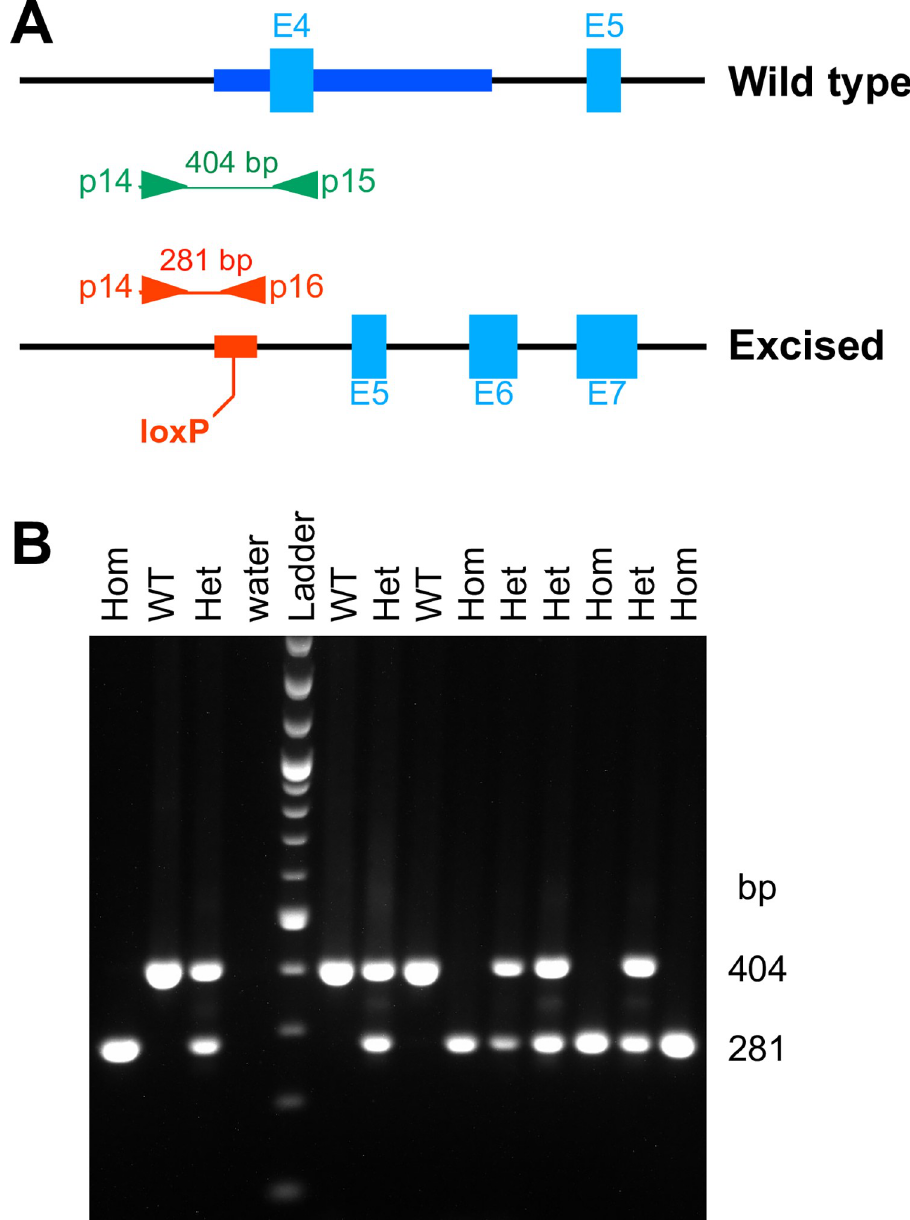
Fig 6. Production of excised Poldip2 mice. New floxed Poldip2 mice were crossed with a transgenic Cre deleter to produce animals with a constitutively excised Poldip2 allele. These mice were then backcrossed with wild type C57BL/ 6J to remove the Cre transgene and eliminate mosaicism. A: Design of a genotyping method for the excised Poldip2 allele. The genomic maps show the annealing sites of three primers and corresponding amplicons from wild type (top, green) and excised alleles (bottom, red). The 641 bp region around exon 4 (E4) in wild type, highlighted in dark blue, is replaced in the excised allele by a 95 bp insert (red box) that includes the remaining 34 bp loxP site. The forward primer (p14) anneals to intron 3 and the reverse primers either to exon 4 (p15) or to the loxP insert (p16), ensuring allele specificity. B: Representative agarose gel, following PCR with the three primers above, revealing the presence of viable homozygous pups at weaning